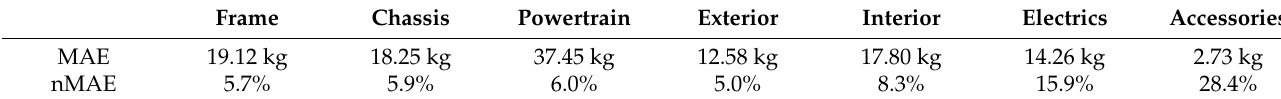
Table 3. Overview of the MAE and nMAE for the different modules.